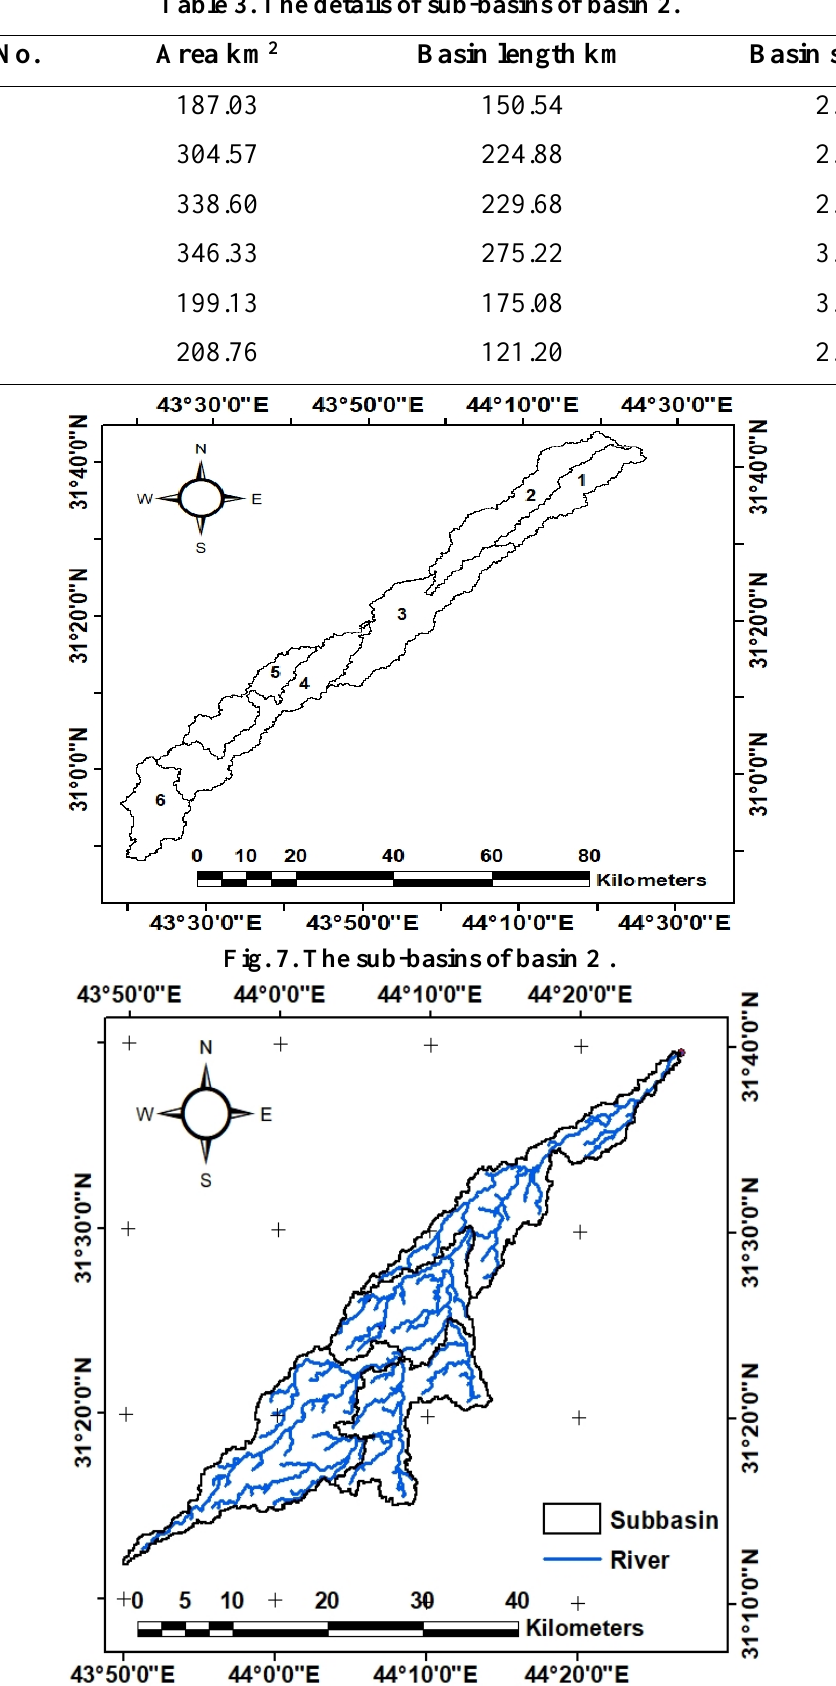
Fig. 8. The distributary's streams of the basin